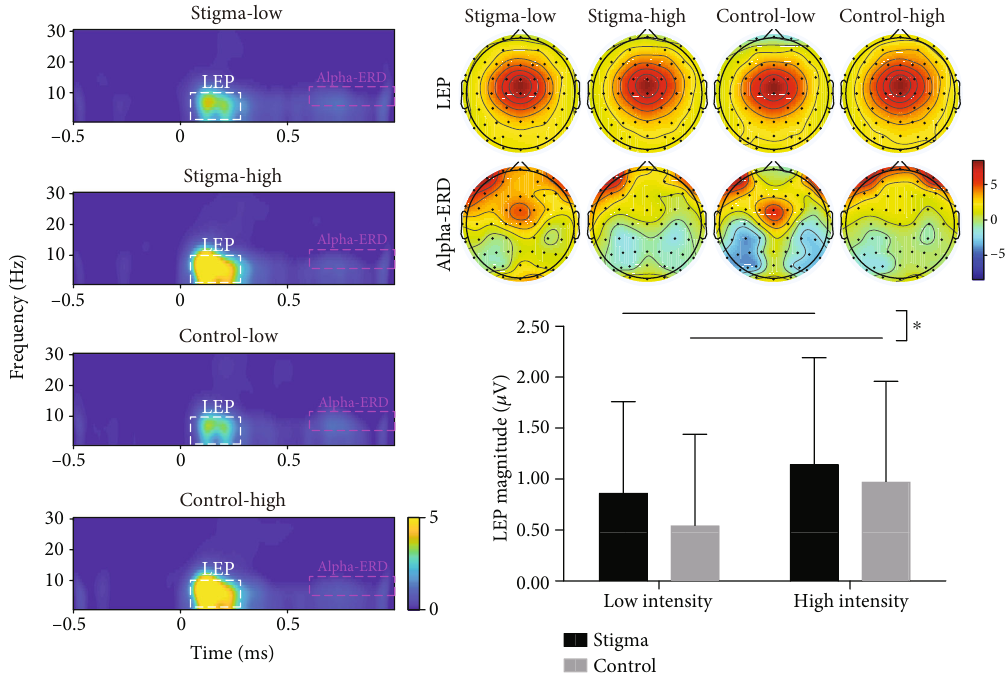
Figure 5: Laser-evoked modulations of EEG responses in four experimental conditions. LEP magnitude in the stigma condition was signi fi cantly larger than that in the control condition ( ∗ p < 0 : 05 ). No signi fi cant di ff erence was observed in alpha-ERD magnitude measured at occipital electrodes (PO3, PO4, PO7, PO8, O1, and O2) between the sigma and control conditions. Scalp topographies of response magnitudes in four conditions were displayed for each time-frequency feature (i.e., LEP and